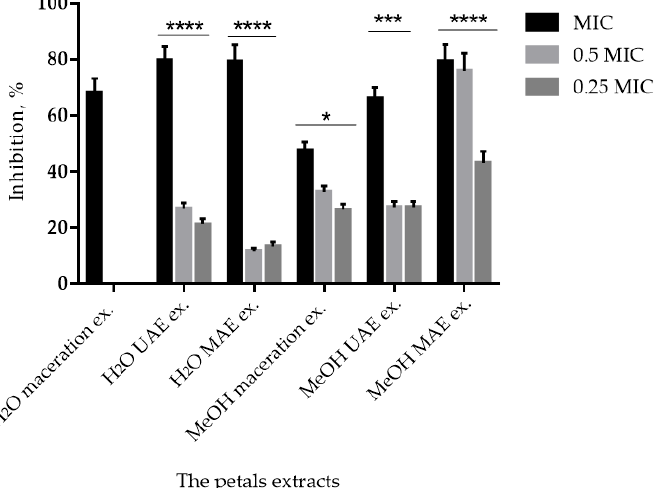
Figure 1. Biofilm formation of S. lugdunensis (Ibis 2996) after treatment with P. tenuifolia extracts. The asterisks represent statistical significance: * p ≤ 0.05; ***, p ≤ 0.001, ****, p ≤ 0.0001.